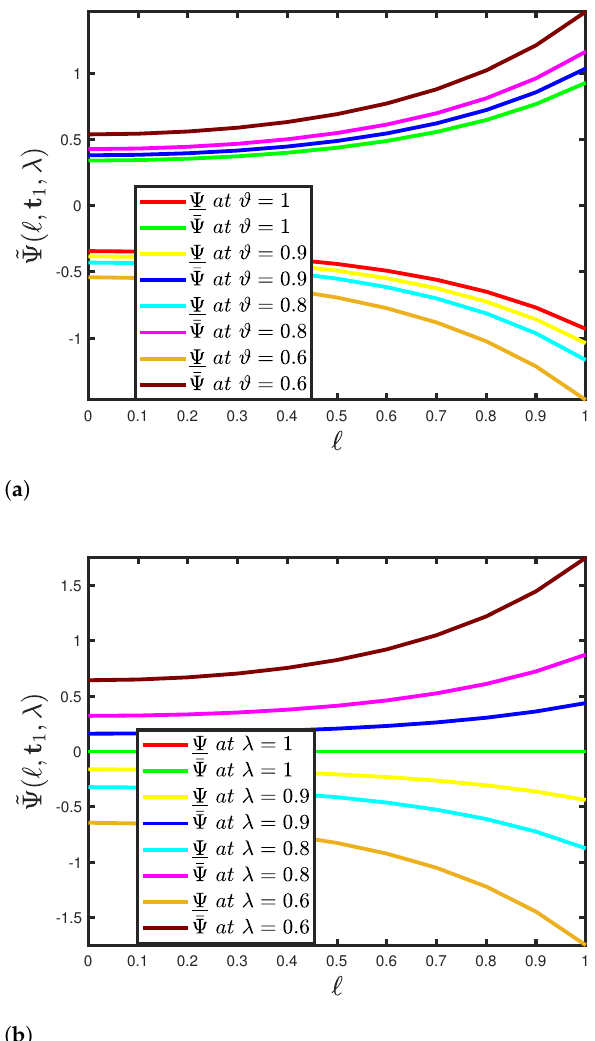
Figure 15. Two-dimensional simulation of ˜ Ψ ( (cid:96) , t 1 ; λ ) of Problem (4): ( a ) Ψ ( (cid:96) , t 1 ; λ ) and ¯ Ψ ( (cid:96) , t 1 ; λ ) when fuzzy ABC is considered to have an uncertainty parameter λ ∈ [ 0,1 ] and t 1 = 0.7; and ( b ) Ψ ( (cid:96) , t ) and ¯ Ψ ( (cid:96) , t ) when fuzzy ABC is considered to have a fractional order ϑ = 0.7 and 1 ; λ 1 ; λ t 1 =